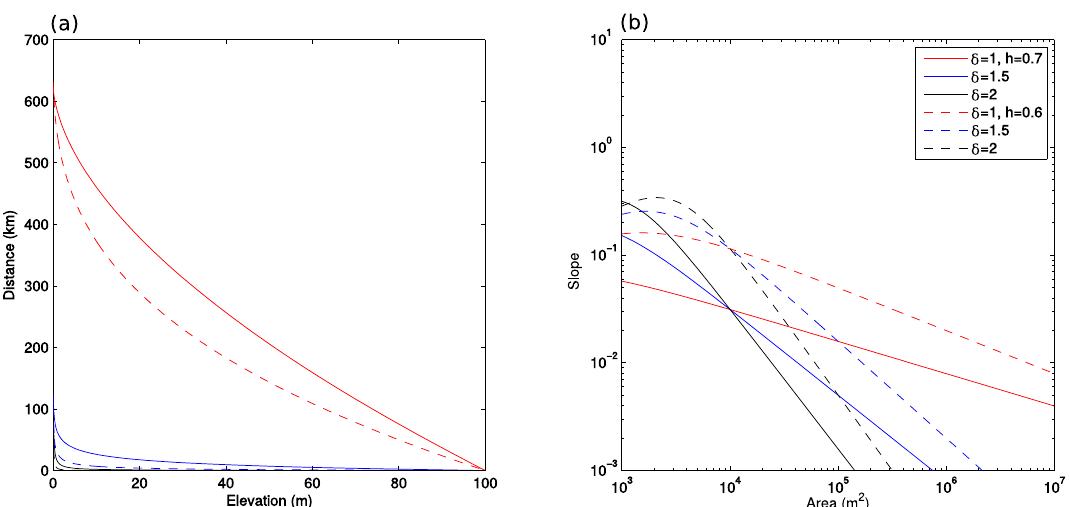
Figure A2. (a) Steady-state elevation and (b) slope–area relationship for the numerical solution to 1-D sediment transport (Eq. 8) for which the area, a , is taken to be related to distance x by a = x p , where p = 1 /h and h is the Hack exponent. Red lines are for the case in which n = 1, blue lines for n = 1 . 5, and black lines for n = 2. Solid lines are for h = 0 . 7. Dashed lines are for h = 0 .